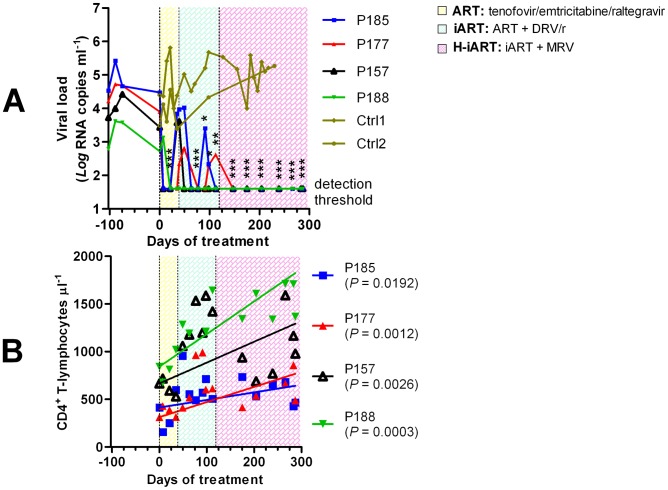
Viro-immunological control of antiretrovirally treated macaques chronically infected with SIVmac251.Panel A: Plasma viral loads. Panel B: CD4 counts. The sequential treatments are represented by the colored areas. Asterisks represent the significant differences from baseline values (respectively *
P<0.05; **
P<0.01; ***
P<0.001), as calculated by Bonferroni's test. The values corresponding to the different macaques, whose denominations are given in the legends, are shown by the different symbols and connecting lines. As a comparison, panel A shows the viral loads dynamics of two untreated macaques (olive).